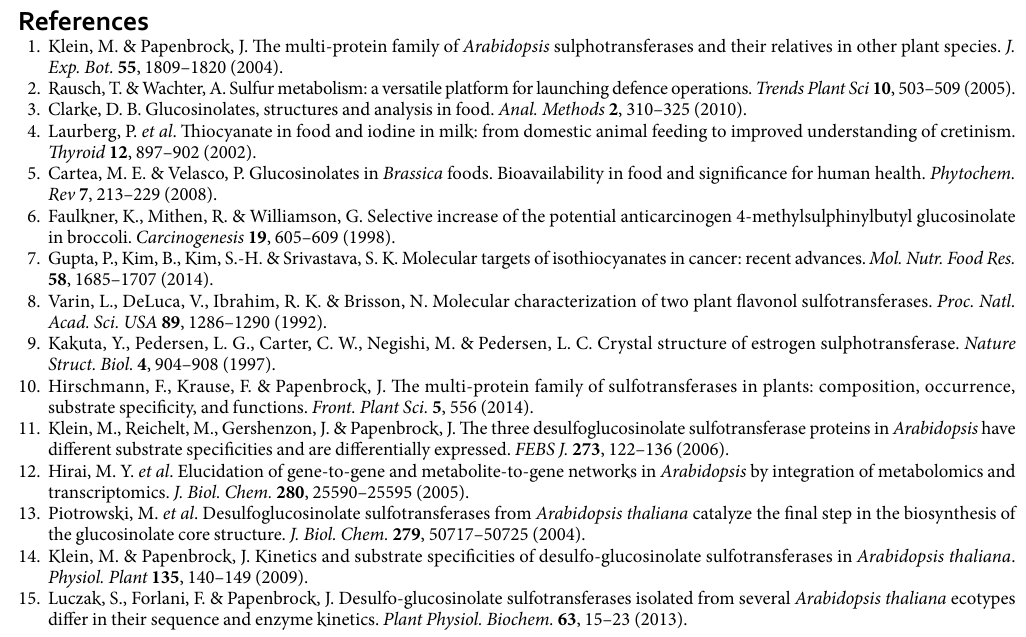
triplicate. The two-dimensional non-linear least squares fit of the measured data with donor PAPS and inhibitor PAP as variables were performed. IgorPro V4.00 (WaveMetrics Inc., Lake Oswego, USA) was used for nonlinear